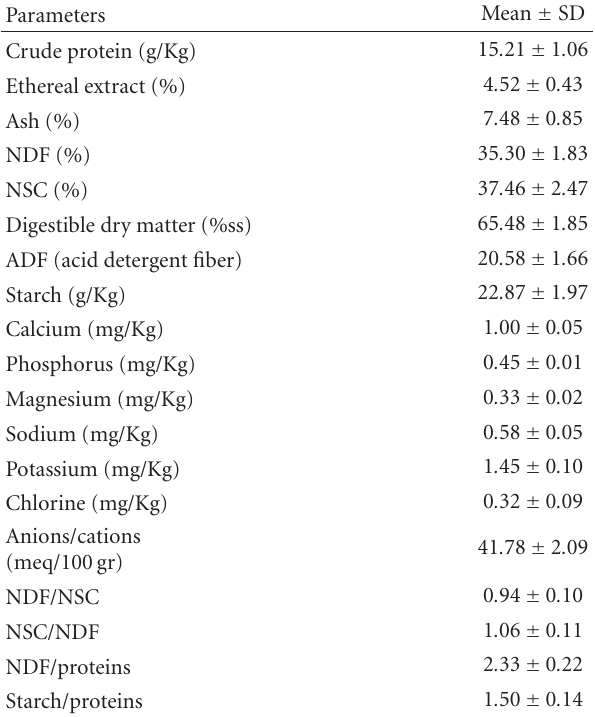
Table 1: Mean values of the chemical composition of the diet administered to 216 cows randomly selected from 20 dairy